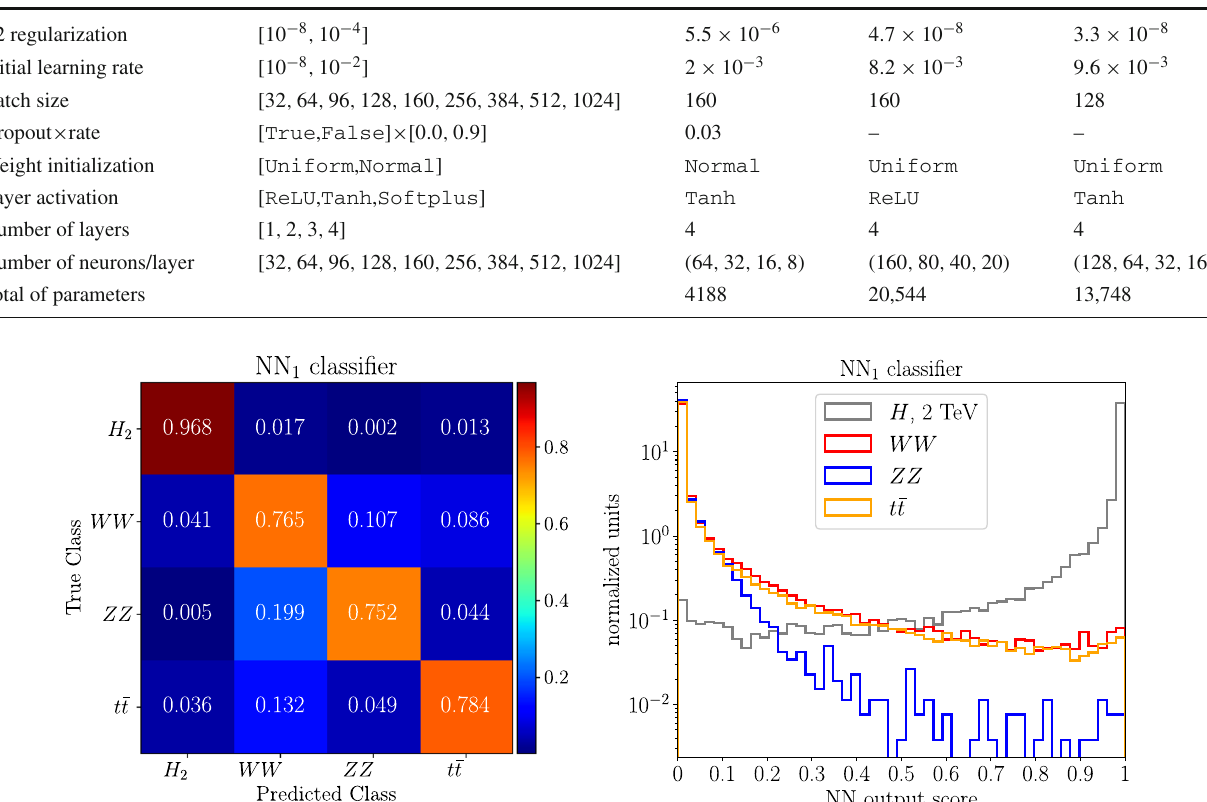
Table 1 Hyperparameters and architecture of the neural network classifiers to clean Higgs boson signals of 1, 1.5 and 2 TeV masses from its SM backgrounds. No dropout layers were needed in the 1.5 and 2 TeV cases Hyperparameter/arch